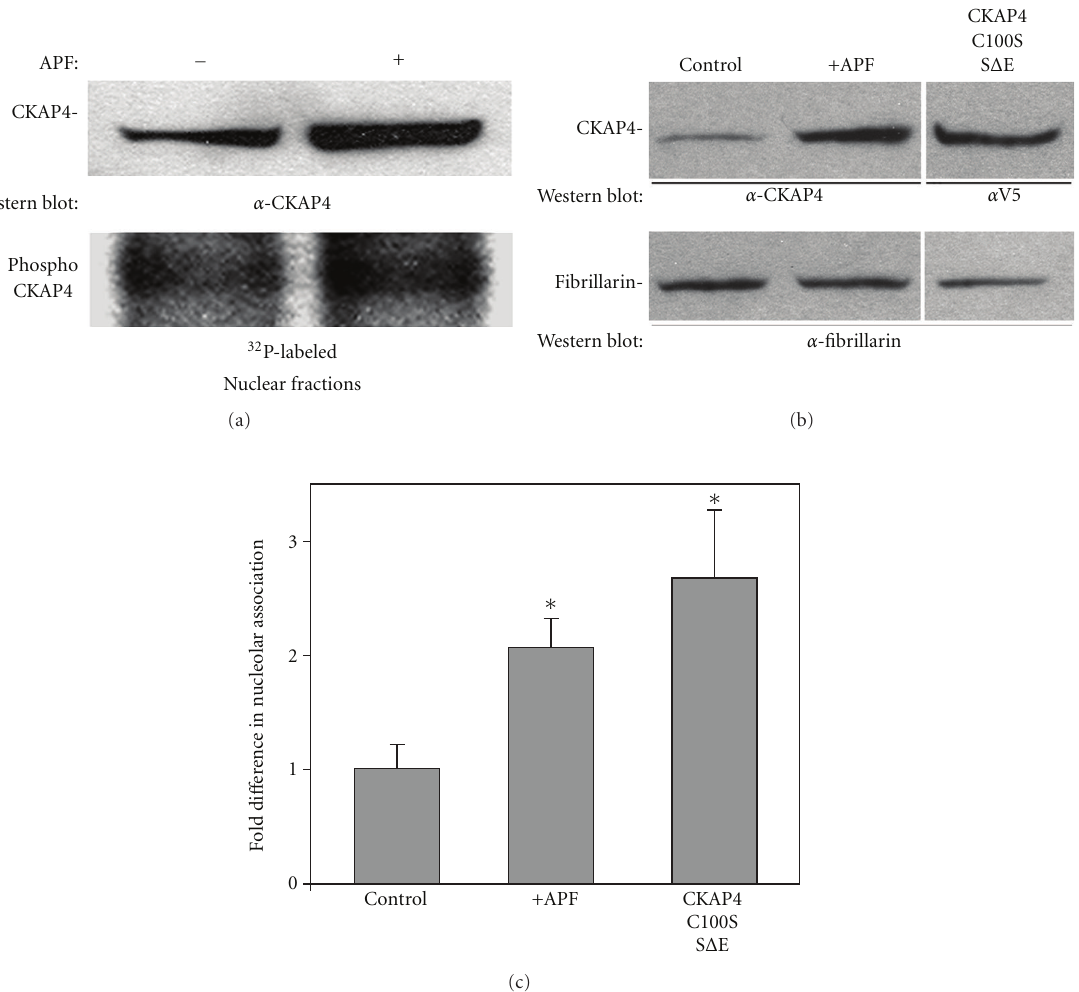
Figure 5: Nuclear CKAP4 is phosphorylated following APF-induced translocation . (a) CKAP4 in the nuclear fraction was phosphorylated to the same degree in APF-treated and control cells as demonstrated by metabolic labeling with γ 32 P-ATP. The ratio of the CKAP4 phosphorylation signal over the corresponding CKAP4 Western Blot signal was approximately the same for both (1.00 versus 0.975; APF treated versus control). HeLa cells at ∼ 80% confluence in 10 cm dishes were serum starved for 3 hours then 150 μ Ci γ 32 P-ATP was added to each dish